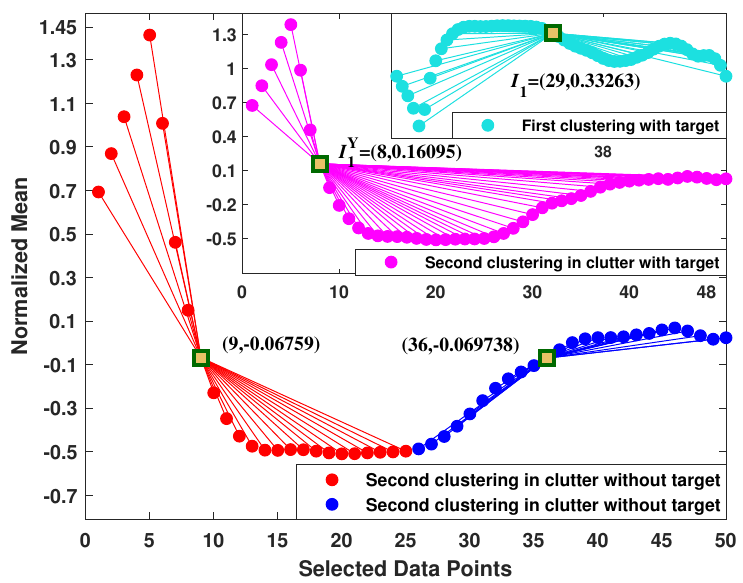
Figure 13. Visualization of the formed clusters when Q 2 = 2.